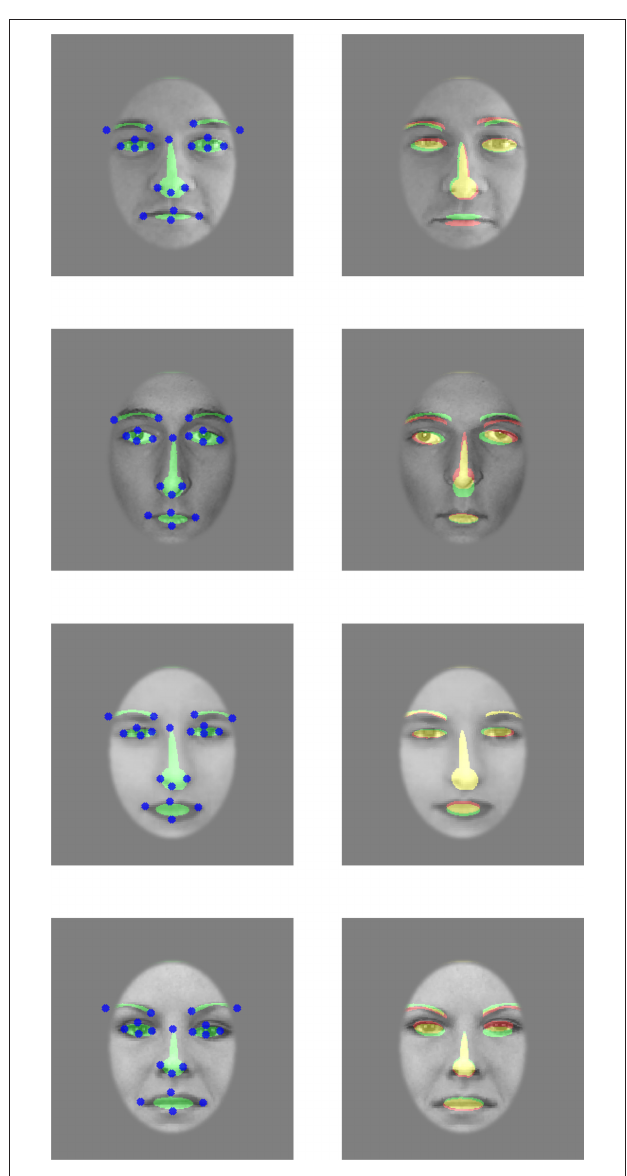
Figure 3 | Creation of face stimuli using real-world interattribute distances. Leftmost column: In Experiment 2, feature masks – shown in translucid green – were bestfitted to the aligned annotations – represented by blue crosses. Rightmost column: In Experiment 2a, these feature masks were displaced according to the feature positions of another face of the same gender. Translucid green areas reproduce the feature masks of the leftmost column; translucid red areas represent the same feature masks after displacement; and translucid yellow areas represent the overlap between these two sets of feature